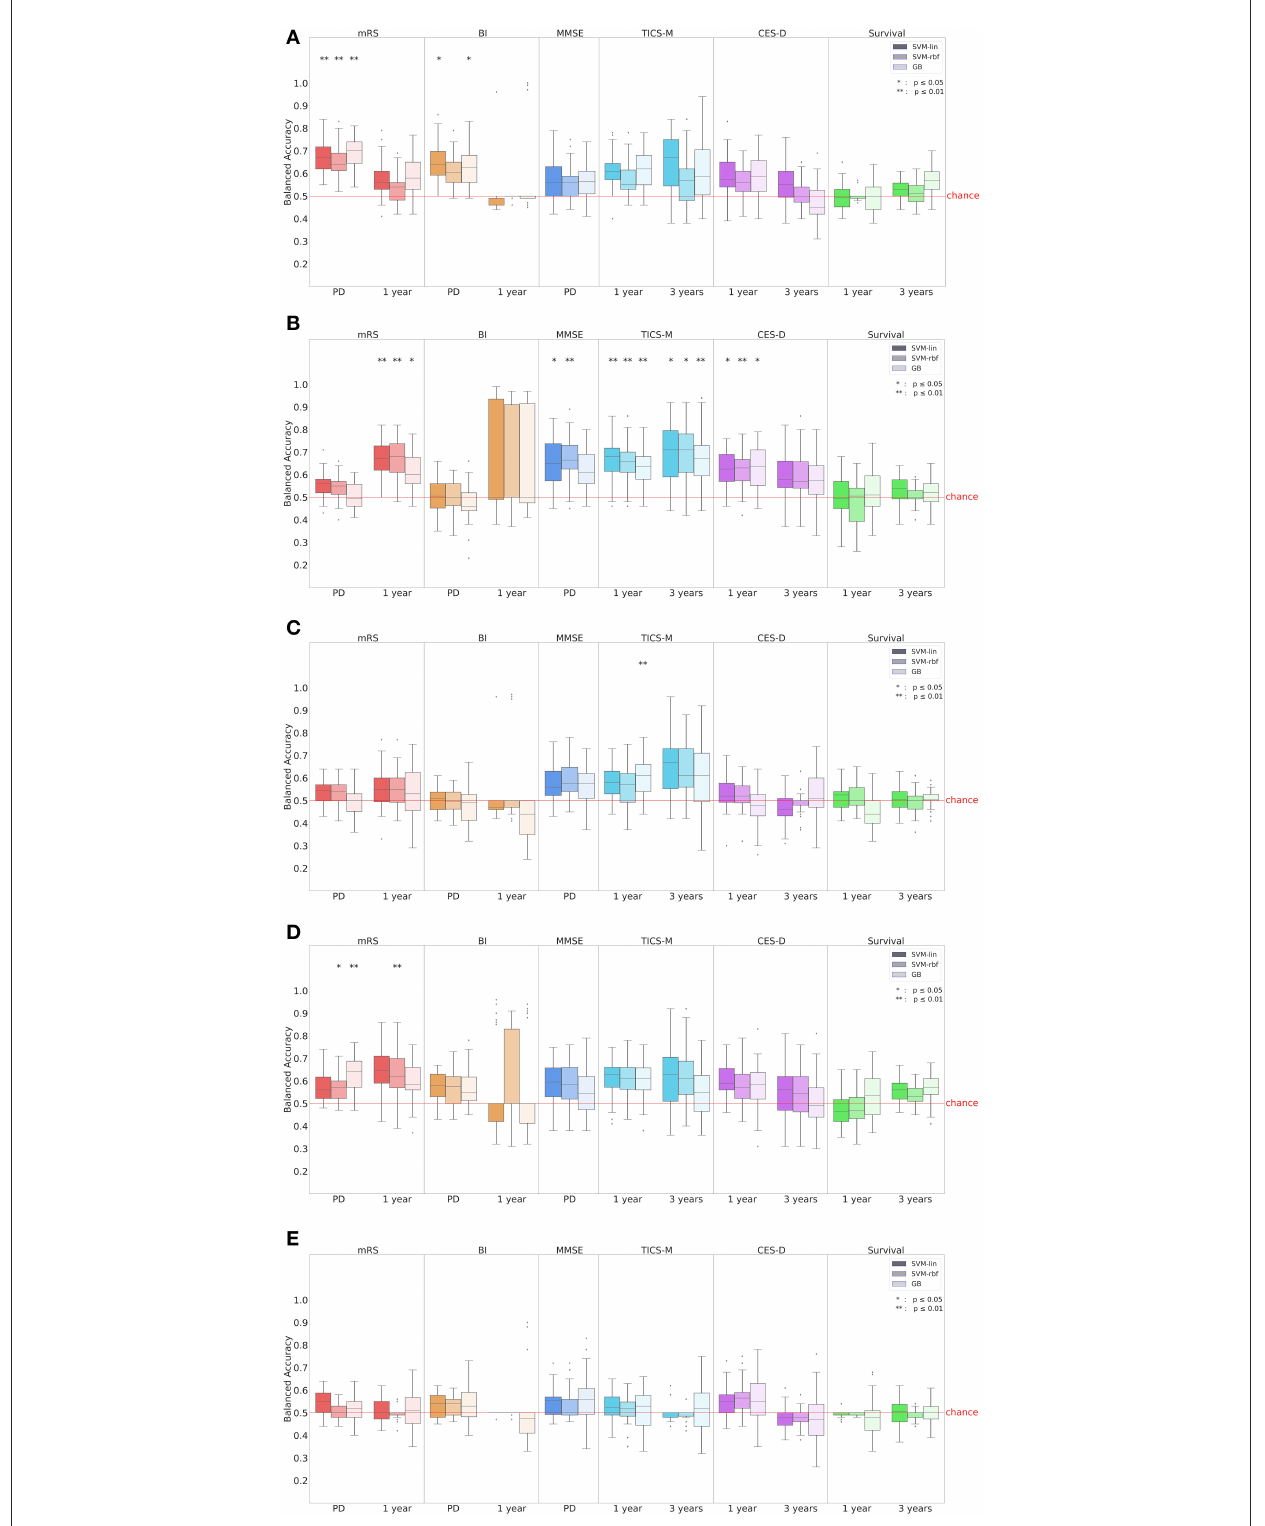
FIGURE3 Prediction performance in balanced accuracy (BA) for all outcomes, time points and input subdomains. In (A) all input parameters were considered while (B–E) show the results of the (B) demographic, (C) clinical, (D) serological and (E) MRI input subdomain. Results for BI after 1 year were unreliable due to the extreme class imbalance in the dataset (see Table 2). mRS, modified Rankin Scale; BI, Barthel Index; MMSE, Mini-Mental State Examination; TICS-M, Modified Telephone Interview for Cognitive Status; CES-D, Epidemiologic Studies Depression Scale; SVM-lin, Support Vector Machine with linear kernel; SVM-rbf, Support Vector Machine with radial basis function kernel; GB, Gradient Bossting Classifier; MRI, Magnetic resonance